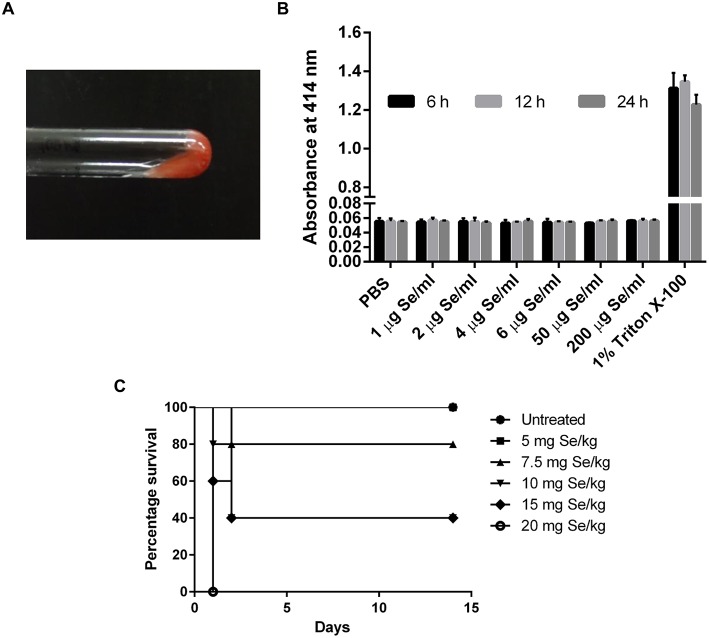
(A) LAL gel clot assay showing no clot formation in the tested SeNP samples. The image is representative of all the concentration tested. (B) Absorbance at 414 nm indicated no hemolysis of RBC upon treatment with different concentrations of SeNPs for 6, 12, and 24 h. The graph is the representation of three independent experiments. (C) Percentage survival of C3H/HeJ mice subjected to the oral dosing of different concentrations of L-selenomethionine.